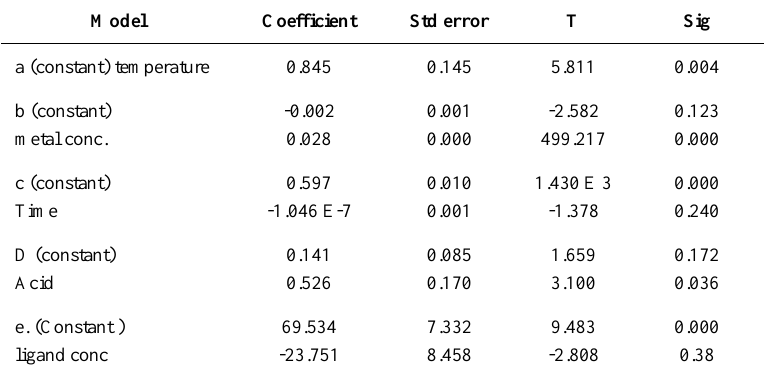
Table 7. The results of regression analysis for the preparation of Fe(III) H 2 SAL complex